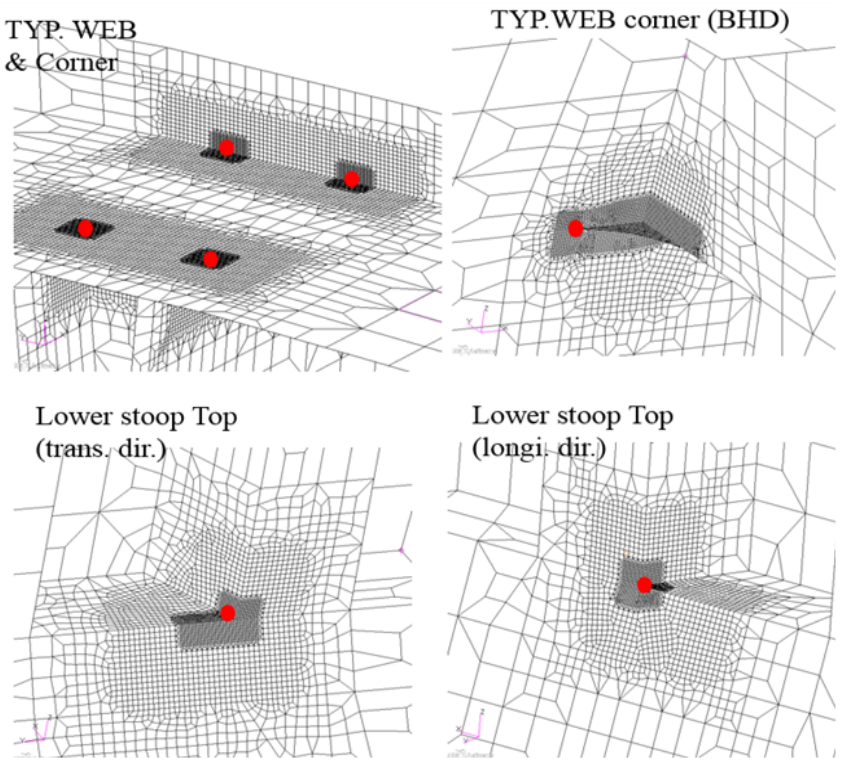
Figure 5. FE analysis modeling (critical area).